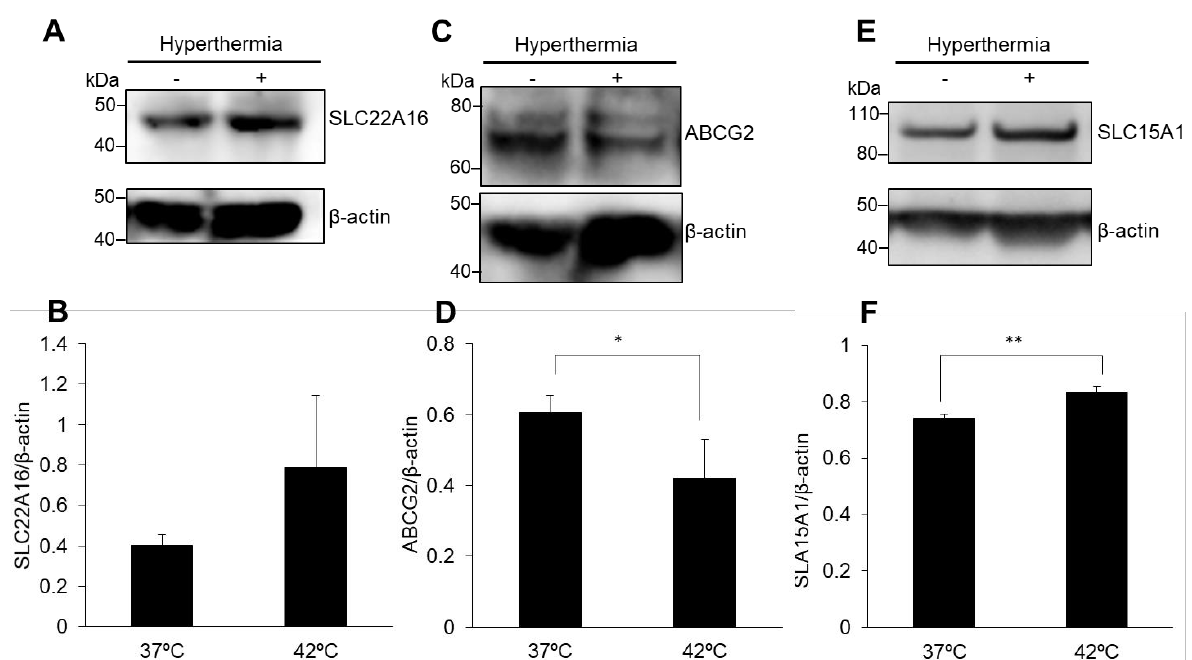
Figure 4. Western blot analysis of each transporter expression. SLC22A16 ( A , B ), ABCG2 ( C , D ) and SLC15A1 ( E , F ) were normalized to β -actin expression. Data are expressed as the mean ± SD ( n = 3). * p < 0.05, ** p < 0.01. Student’s t -test.